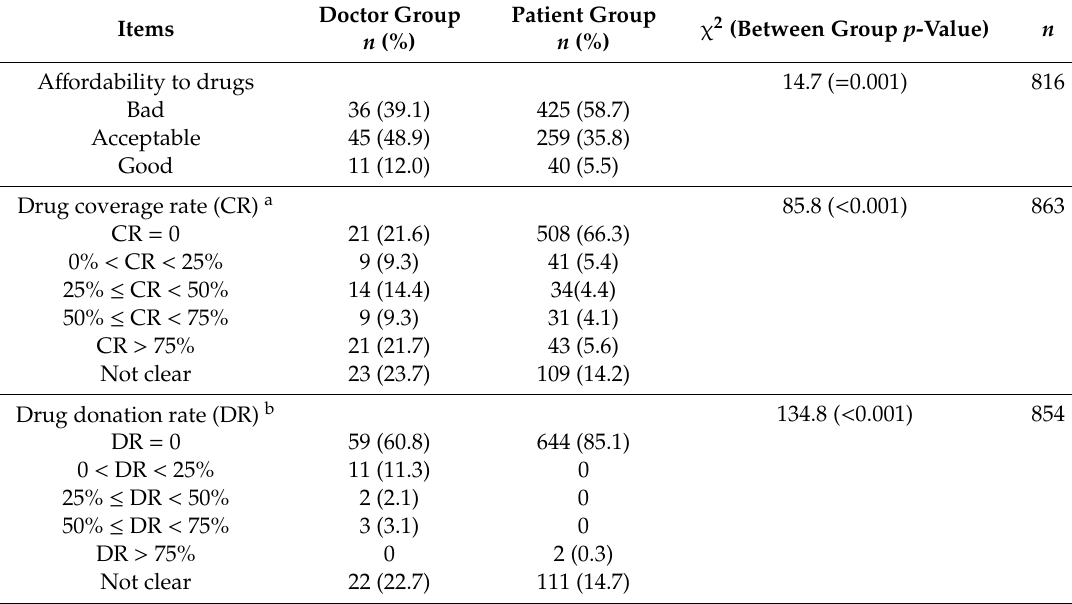
Table 4. Perceived payment levels of drugs for rare diseases between the two